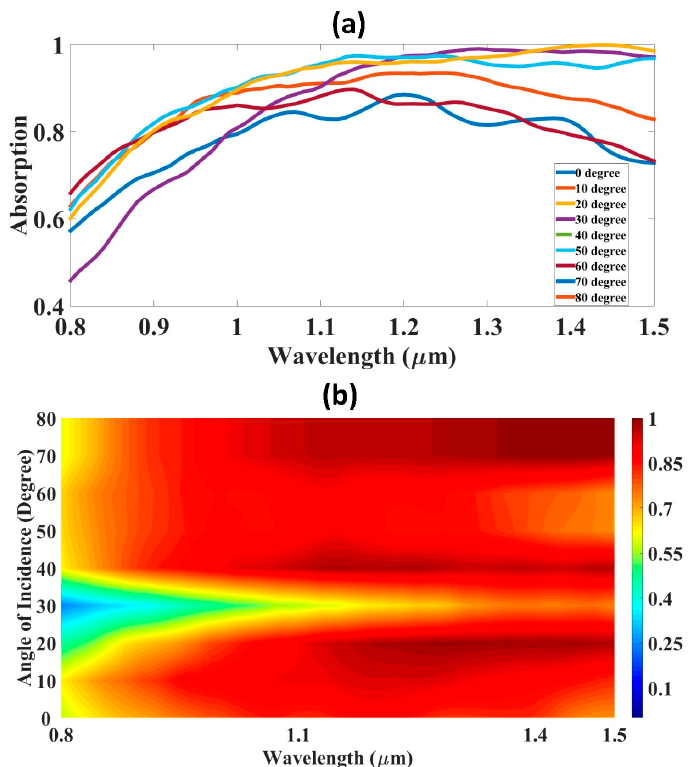
Figure 7. Absorption for variations in angle of incidence. ( a ) Plot indicating the absorption in 0 to 80 degrees. ( b ) Absorption for variations in wavelength and angle of incidence in which high absorp- tion is indicated with a red color and low absorption is indicated with a blue